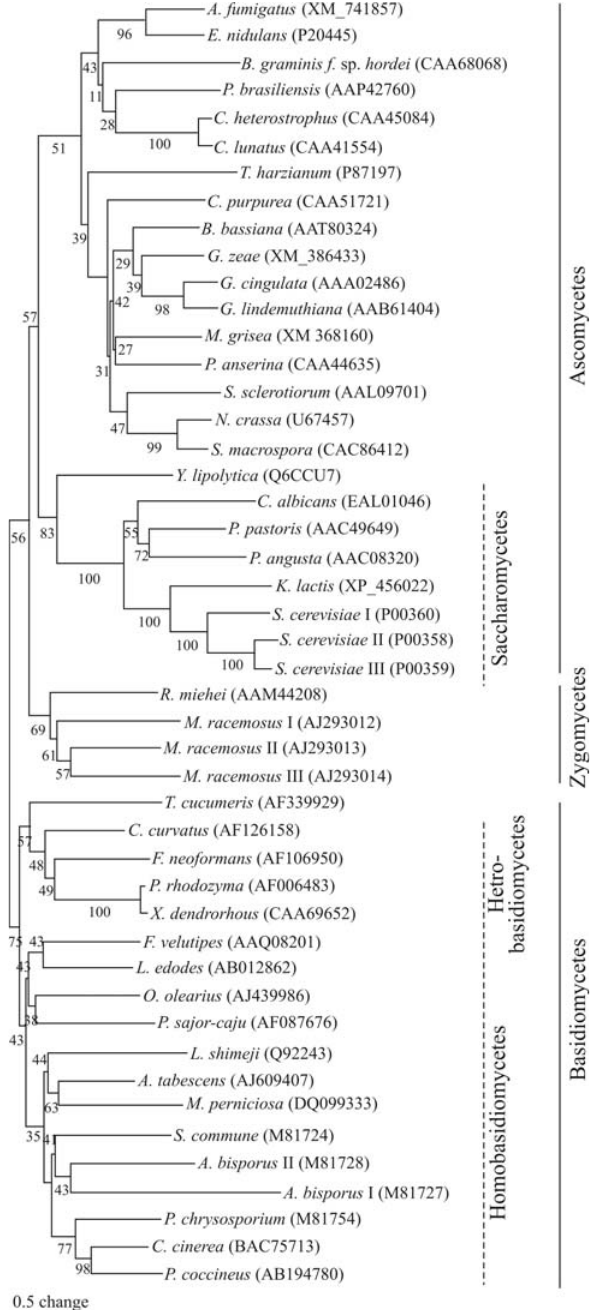
Figure 2 - An unrooted phylogenetic tree showing the relationship be- tween GAPDH proteins from M. perniciosa and other fungi (GenBank ac- cession numbers are indicated in parentheses). The tree was built using the neighbor-joining method (Saitou and Nei, 1987). The numbers above or below each horizontal line correspond to the frequency of each branch in 1000